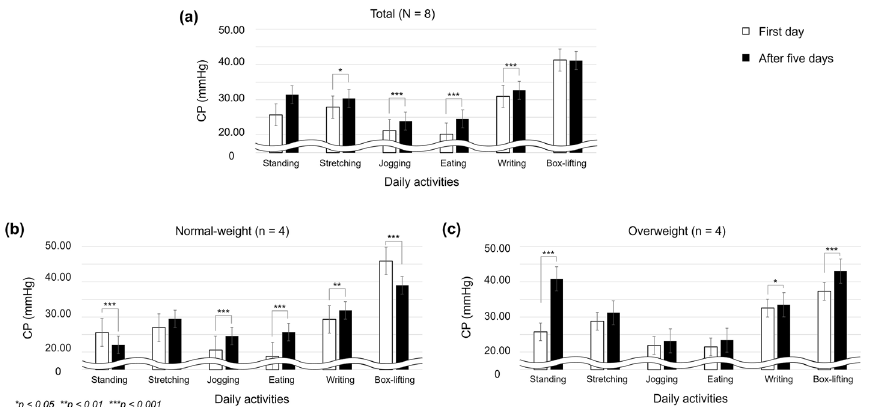
Fig. 5 Results of clothing pressure by different daily